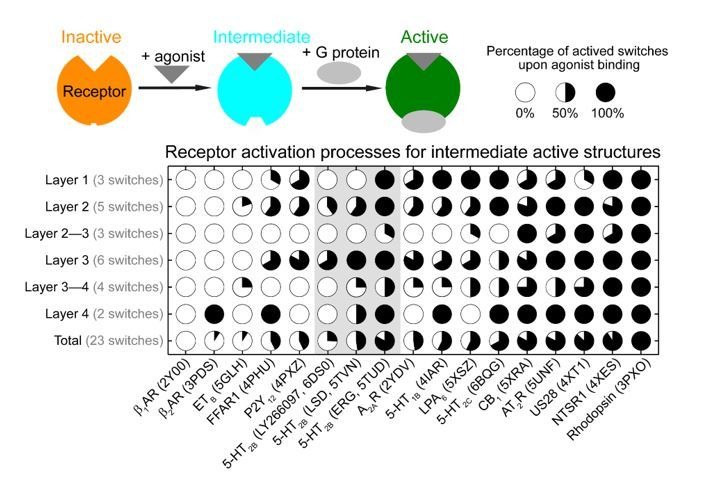
Receptor activation process via intermediate structures (i.e., only agonist but not G protein bound structures) are in receptor- and ligand-specific manner, thereby highlighting the modular nature and complexity of the activation pathways.